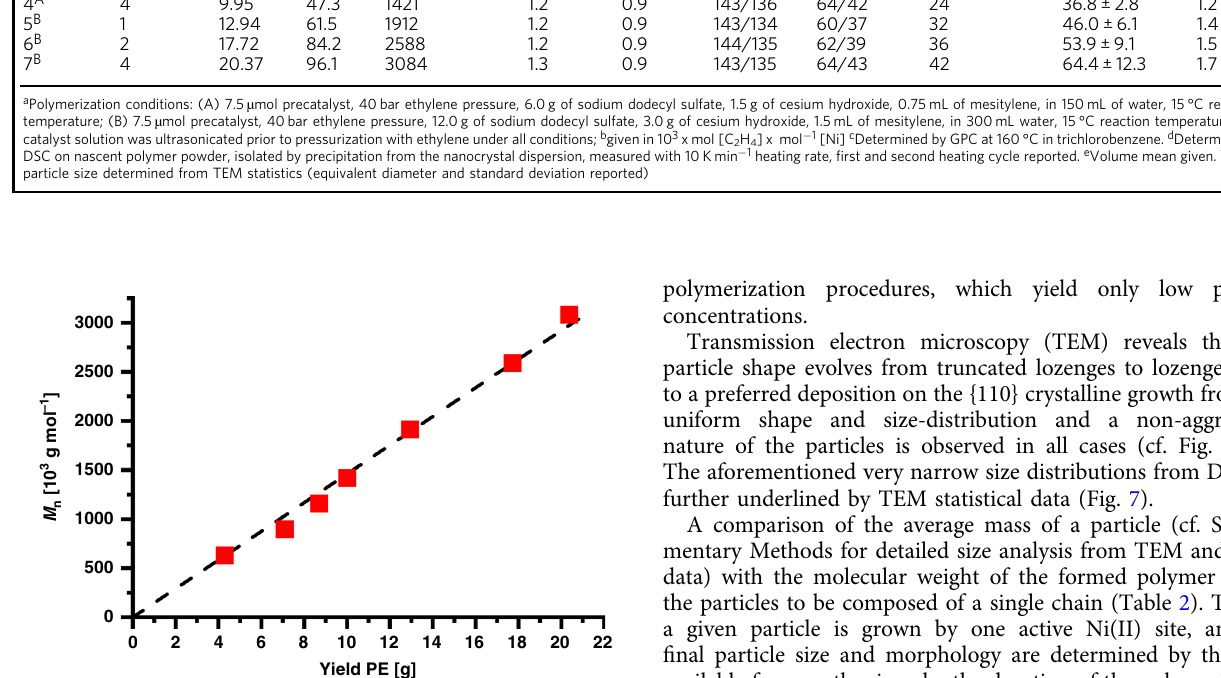
Fig. 4 Molecular weights of the polyethylenes formed versus yields. The data for aqueous polymerization experiments, with reaction times varying from 0.5 to 4 h (data from Table 2)